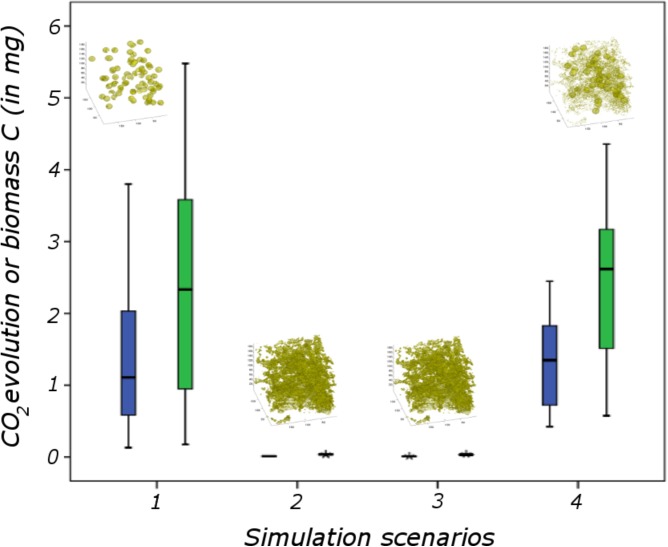
Boxplot diagram of simulated CO2 production by fungi in soil samples with an identical Particulate Organic Matter (POM) content of 3%. The abscissa represents different scenarios with, respectively, (from left to right) 49.95, 51.06, 56.73, and 60.12% of POM accessible at pore-solid interfaces. Individual samples differ in the way POM is distributed in the pore space (Modified from Falconer et al., 2015).